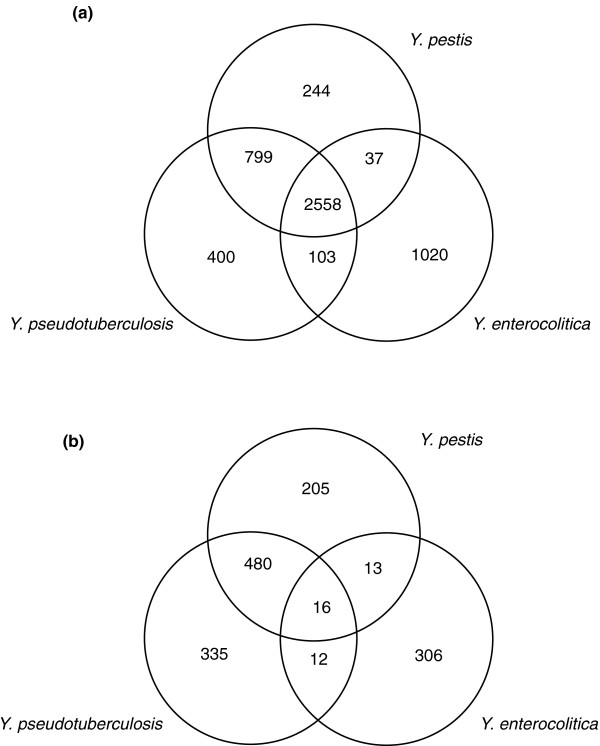
Distribution of protein clusters across Y. enterocolitica 8081, Y. pestis CO92, and Y. pseudotuberculosis IP32953. (a) The Venn diagram shows the number of protein clusters unique or shared between the two other high virulence Yersinia species (see Materials and methods). (b) The number of shared and unique clusters that do not contain a single member of the eight low human virulence genomes sequenced in this study.